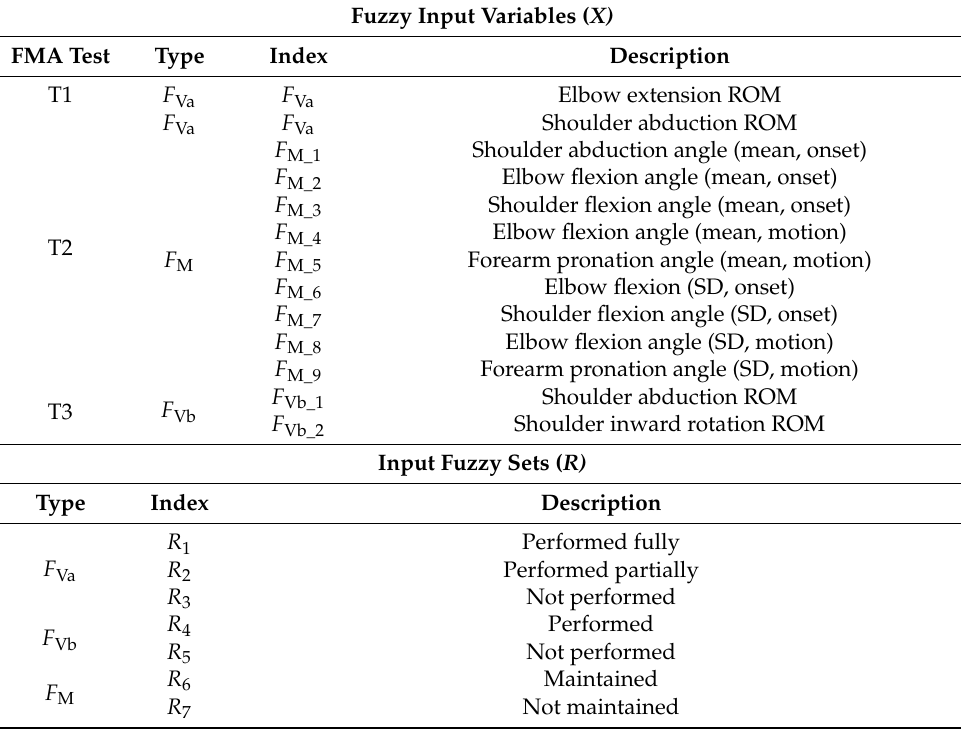
Table 2. Fuzzy input variables and their fuzzy sets.